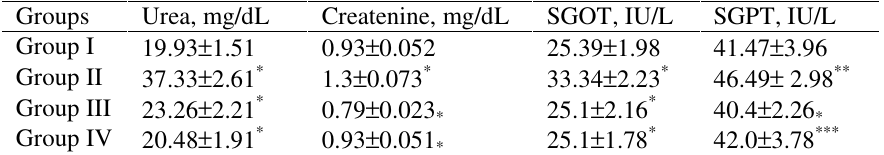
Table 2. Levels of Urea, Createnine, SGOT and SGPT in control and experimental rats. Groups Urea, mg/dL Createnine, mg/dL SGOT, IU/L SGPT, IU/L Group I 19.93 ± 1.51 0.93 ± 0.052 25.39 ± 1.98 41.47 ± 3.96 Group II 37.33 ± 2.61